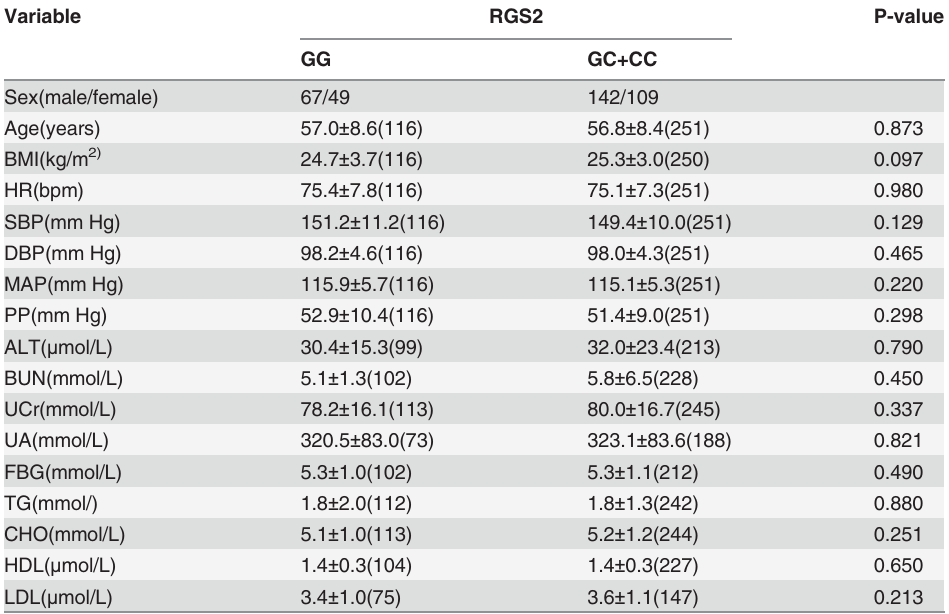
Table 1. Comparison of the baseline characteristics of the eligible patients in the RGS2 (-391, C > G) genotype groups.